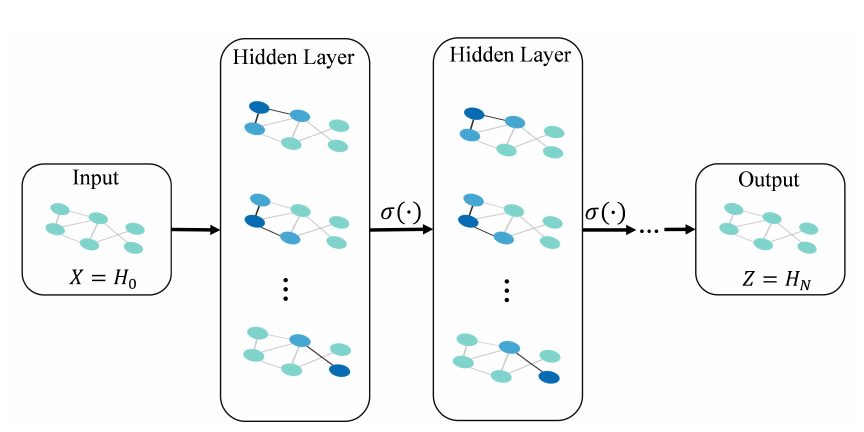
Figure 9. The model architecture of GCN.